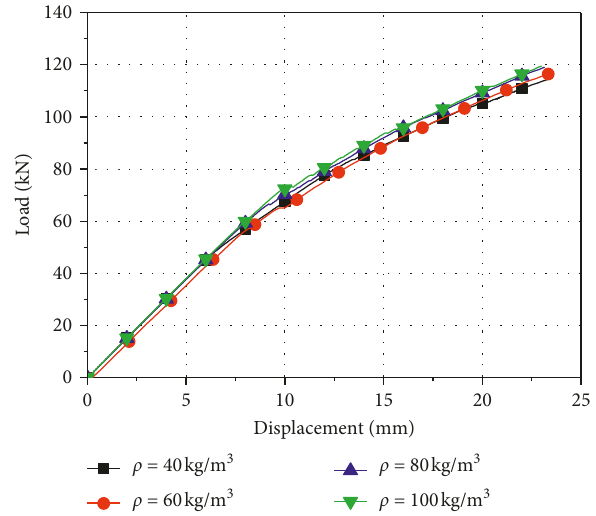
100mm, s 75mm, t s (cid:30) (cid:30) (cid:30)